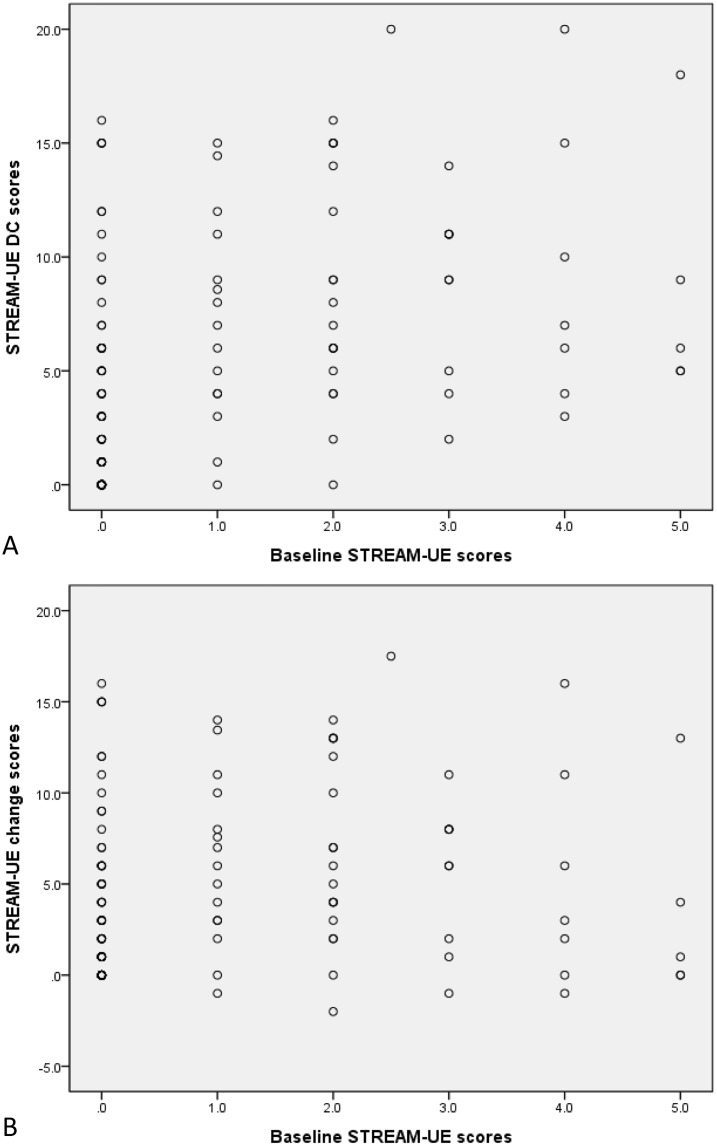
The scatter plots of baseline STREAM-UE scores versus STREAM-UE DC scores (A) and STREAM-UE change scores (B). STREAM-UE = the UE subscale of the Stroke Rehabilitation Assessment of Movement measure. DC = discharge.